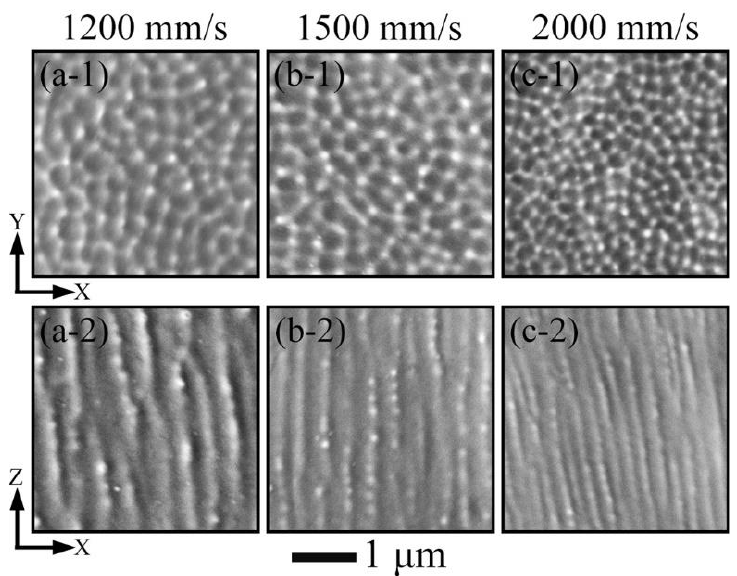
Figure 10. Cell structure on the xy- and xz-plane produced by laser power of 200 W applying scanning speeds of ( a-1 ) and ( a-2 ) 1200 mm/s, ( b-1 ) and ( b-2 ) 1500 mm/s, and ( c-1 ) and ( c-2 ) 2000 mm/s.